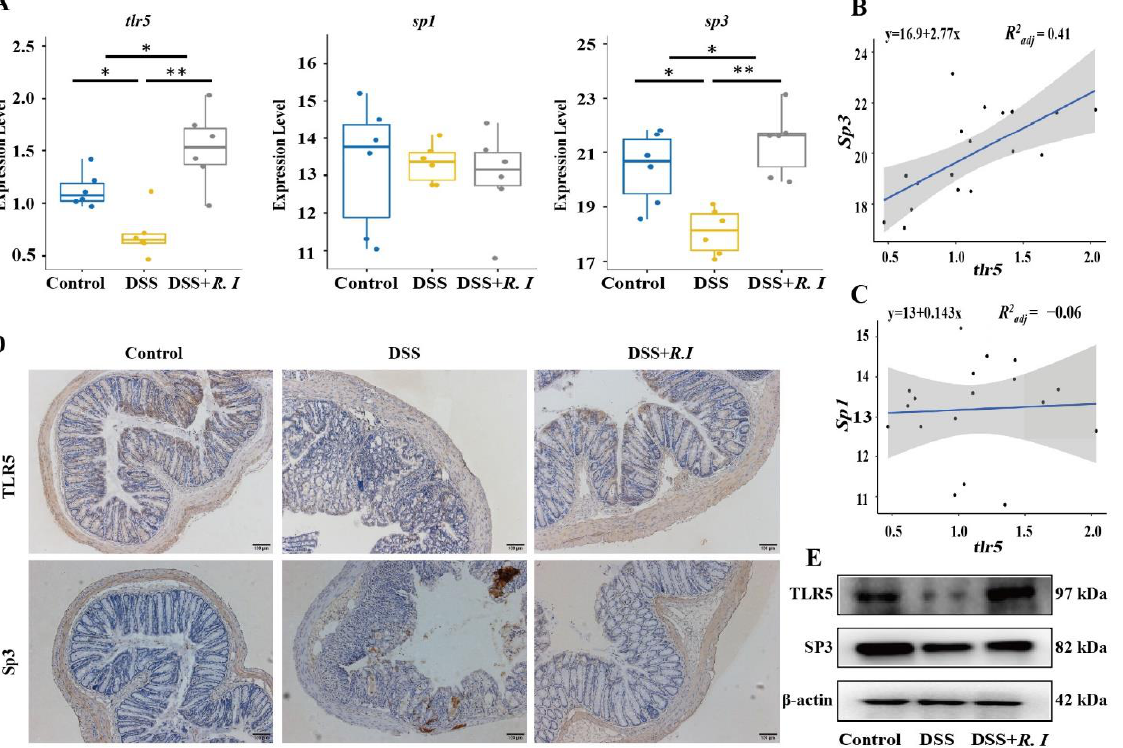
Figure 3. Expression levels of the flagellin recognition receptor TLR5 and its potential transcription factor in the control, DSS and DSS + R. I groups treated mice. ( A ) Expression levels of TLR5, Sp1, and Sp3 in the three groups as determined by RT‒qPCR analysis. ( B ) Correlation analysis between TLR5 and Sp3 in the three groups. ( C ) Correlation analysis between TLR5 and Sp1 in the three groups. ( D ) Representative images of TLR5 and Sp3 immunohistochemical staining in colon sections from the three groups. ( E ) Representative Western blot analysis showing TLR5 and Sp3 in colon sections from the three groups. Control vs. DSS, Control vs. DSS + R. I, and DSS vs. DSS + R. I; * p < 0.05 and ** p < 0.01.